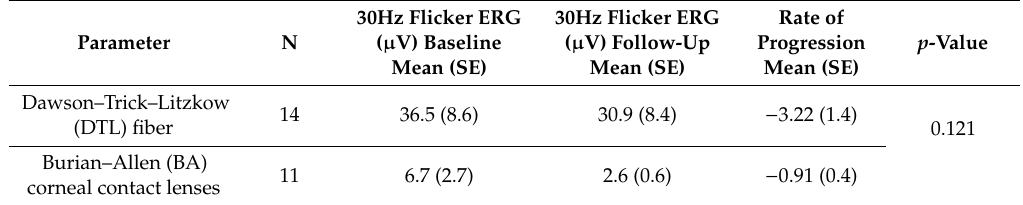
Table 4. Comparison of 30 Hz Flicker electroretinogram (ERG) values recorded using Dawson–Trick– Litzkow (DTL) fiber versus Burian–Allen (BA) corneal contact lens electrodes. Data are summarized as mean and standard deviation (SE).